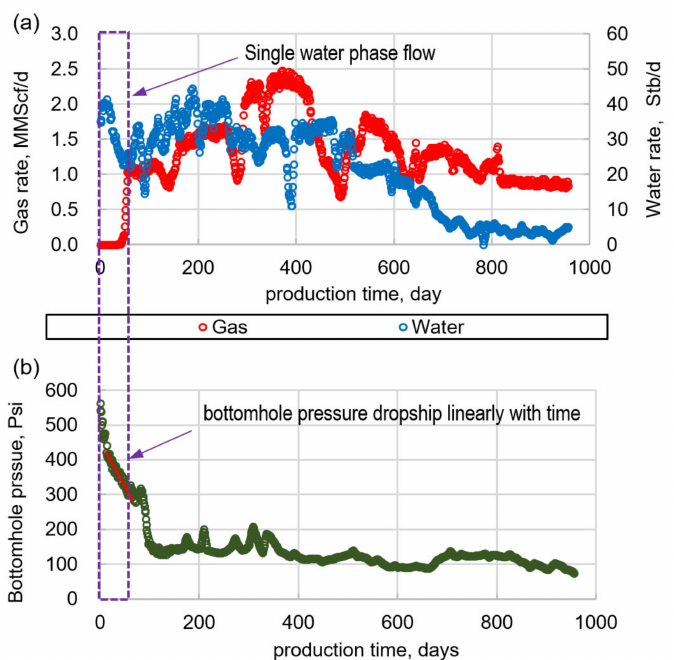
Figure 8. The gas and water production history of the field case: ( a ) water and gas production rate and ( b ) bottom-hole flowing pressure.